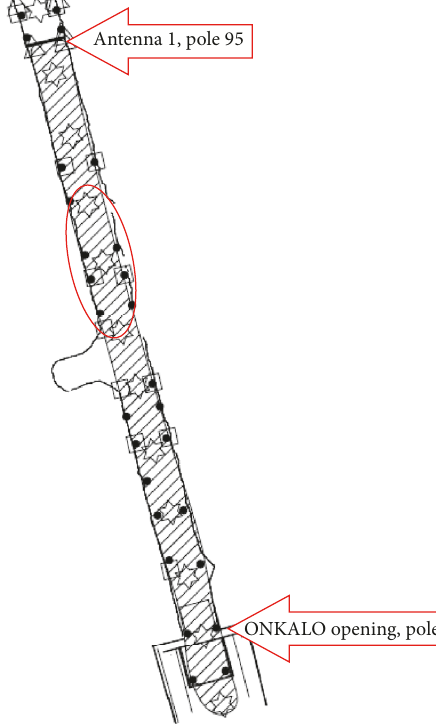
Figure 16: Antenna 1 MRRR area.